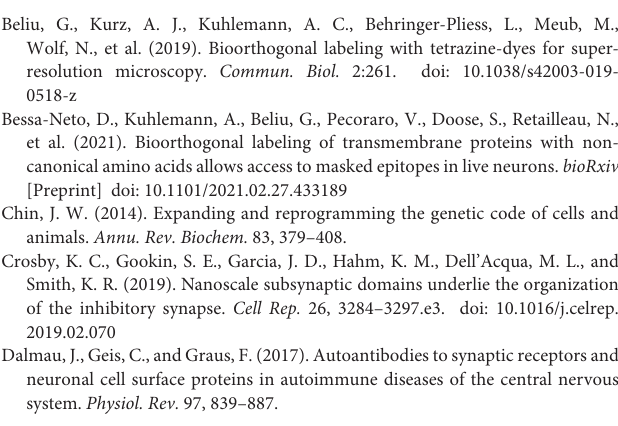
Supplementary Figure 1 | Click sites of GABA-A receptor α 2 subunit (green) SWISS modeled on α 1 subunit template (PDB code: 6HUG). Amber sites (magenta and cyan) were introduced using PCR-based site-directed mutagenesis. The two mutants S181TAG and S201TAG (magenta) showed efficient incorporation of the unnatural amino acid TCO ∗ A, when expressed in HEK-293-T cells and labeled with H-tet-Cy5 ( Figure 2 ). In contrast, the two mutants K73TAG and K274TAG (cyan) showed significantly lower fluorescence labeling. Supplementary Figure 2 | Confocal microscopy of GABA-A receptor S201TAG mutant. Top row: α 2 click-mutant S201TAG shows similar performance as S181TAG for labeling surface α 2 GABA-A receptor subunits by click-chemistry labeling. Modified α 2 subunits are targeted by H-tet-Cy3, and anti-HA antibody labeling is applied to verify incorporation of TCO ∗ . Negative controls omit ncAA application and show minor signal for both tetrazine and HA-tag labeling (-TCO). Scale bar = 5 µ m. Supplementary Figure 3 | Confocal microscopy testing the specific labeling of GABA-A receptor α 1 subunits.GABA-A receptor subunits imaged on the equatorial membrane HEK-293-T cells with coexpression of β 1 and γ 2 subunits to ensure proper surface delivery of receptors using a confocal laser scanning microscope. First row: α 1 click-mutant S181TAG shows slightly lower performance compared to S181TAG in α 2 subunits, click-chemistry labeling of incorporated ncAA TCO ∗ using H-tet-Cy5 (magenta) and HA-Tag labeling (green) serving as positive control for incorporation of the unnatural amino acid. Negative controls include omission of the ncAA after transfection of the S181TAG mutant (middle) and barely no H-tet-Cy5 signal (magenta) on WT α 2 receptors (green) (bottom). Scale bar = 10 µ m. Supplementary Figure 4 | Evaluating effect of fluorophore selection on cluster detection. d STORM images of immunolabeled HA-tag modified (HA-Cy5, magenta) and click-chemistry labeled S181TAG GABA-A receptor α 2 subunits (tet-CF568, green) on identical HEK-293-T cell membranes. Right, DBSCAN cluster analysis shows similar trends toward higher labeling density using click-chemistry labeling (tet, filled symbols) compared to anti-HA (HA, open symbols) antibody labeling, independent of conjugated fluorophore. Scale bar = 2 µ m. Supplementary Figure 5 | Absorption (black), emission (magenta) spectra, and turn-on ratios of Pyr-tet-ATTO643 applied in this study. (a) Absorption and corresponding fluorescence spectrum of Pyr-tet-ATTO643. (b) Relative fluorescence increase of Pyr-tet-ATTO643 normalized on initial fluorescence before the addition of 25 µ M TCO ∗